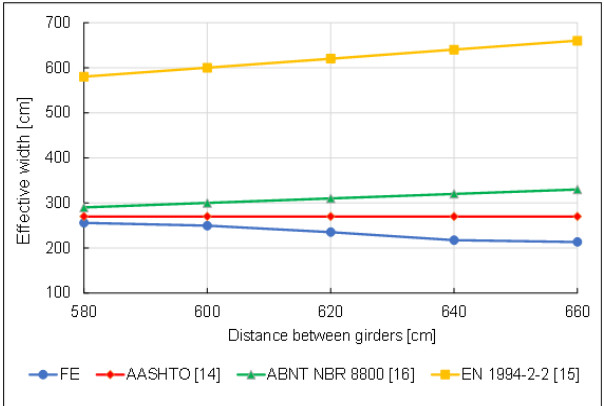
Figure 18. Effective width versus distance between girders for double box